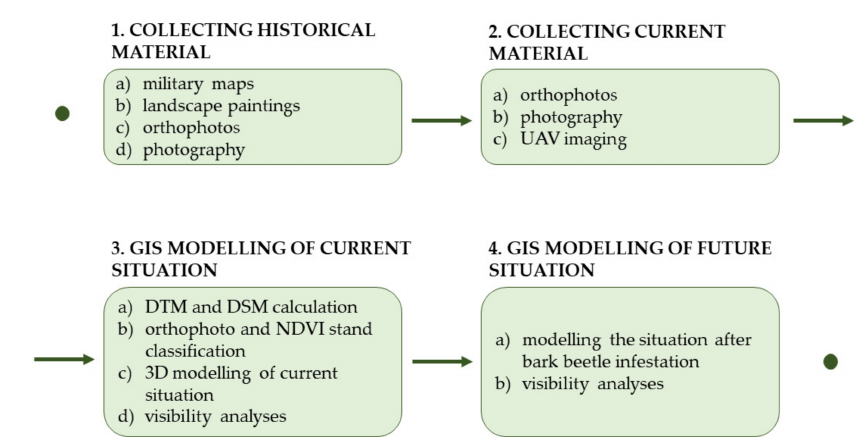
Figure 3. The general scheme of the workflow during the research on Dr á tenick á sk á la. GIS: geographical information system, DTM: digital terrain model, DSM: digital surface model, NDVI: normalized di ff erence vegetation index, and UAV: unmanned aerial vehicle.